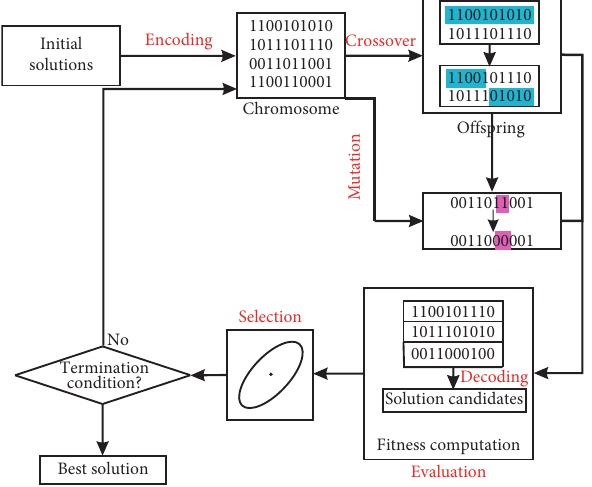
Figure 13: Theory and main steps of GA.